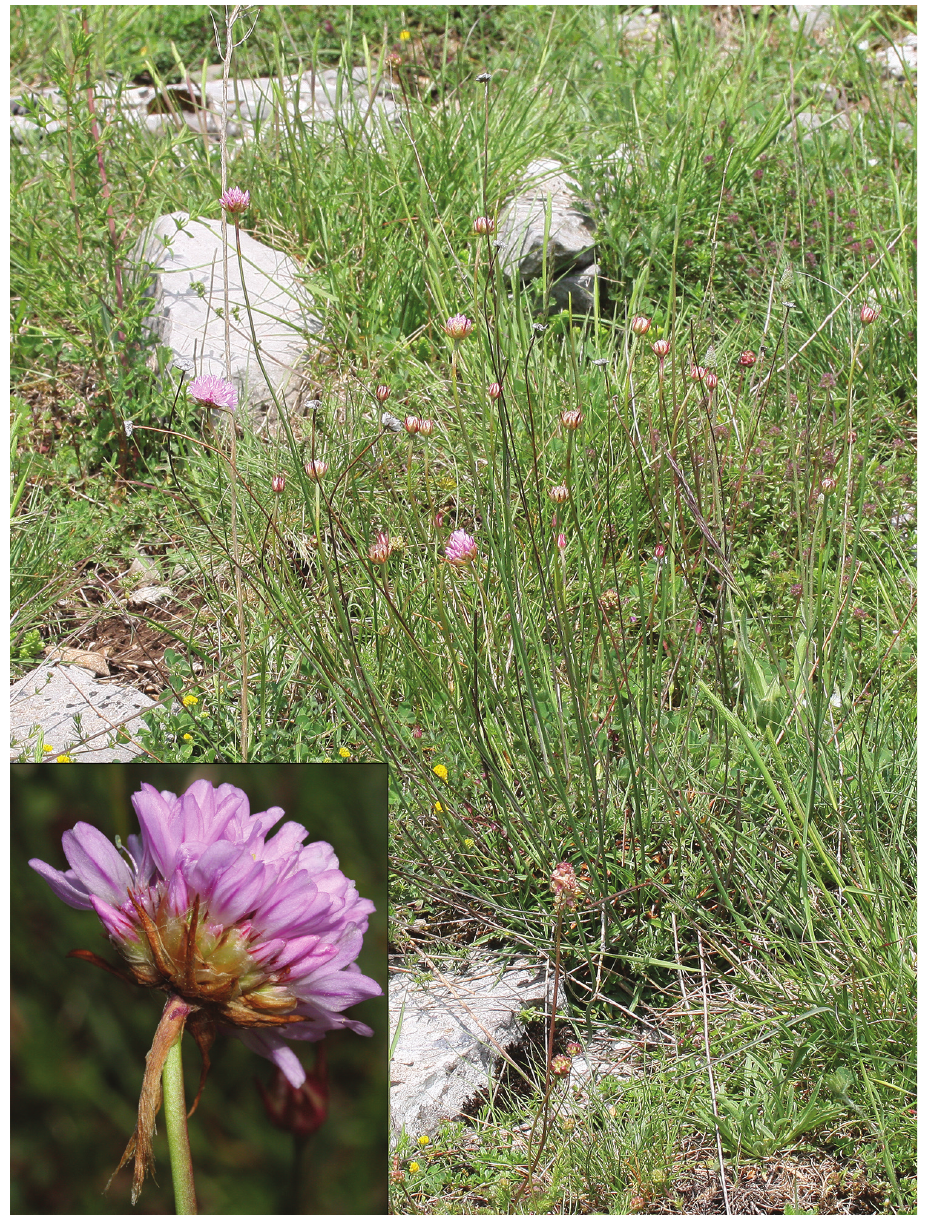
Figure 7. Armeria saviana Selvi in Monte Labbro (Tuscany). Photograph by F.